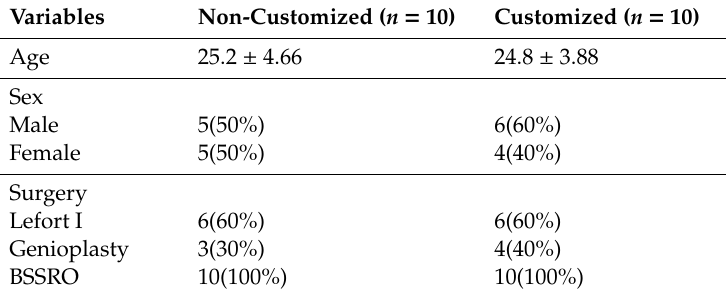
Table 3. Sample characteristics ( n = 20).